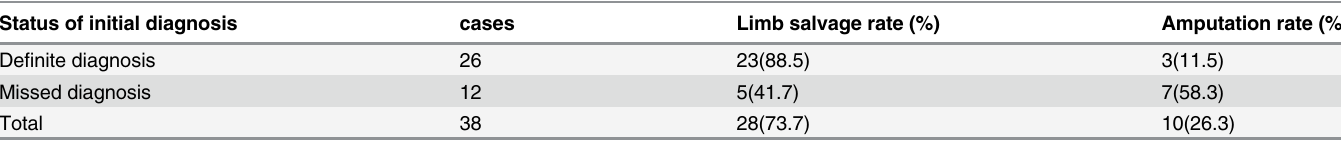
Table 3. The correlation of initial diagnosis and amputation rate. ▲ Status of initial